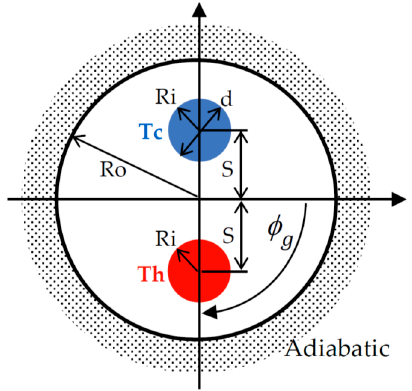
Figure 1. Schematic diagram of the physical configuration investigated.